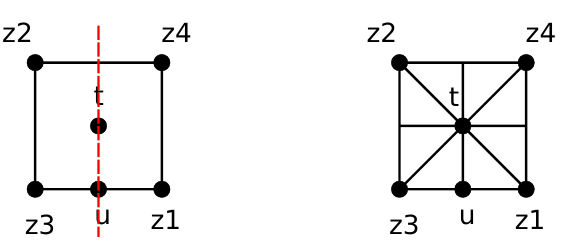
Figure 15 . Left : the involution acts on the toric diagram by reflecting along the dashed red line. Right : a resolution of the toric singularity compatible with the involution, at least at the level of the toric